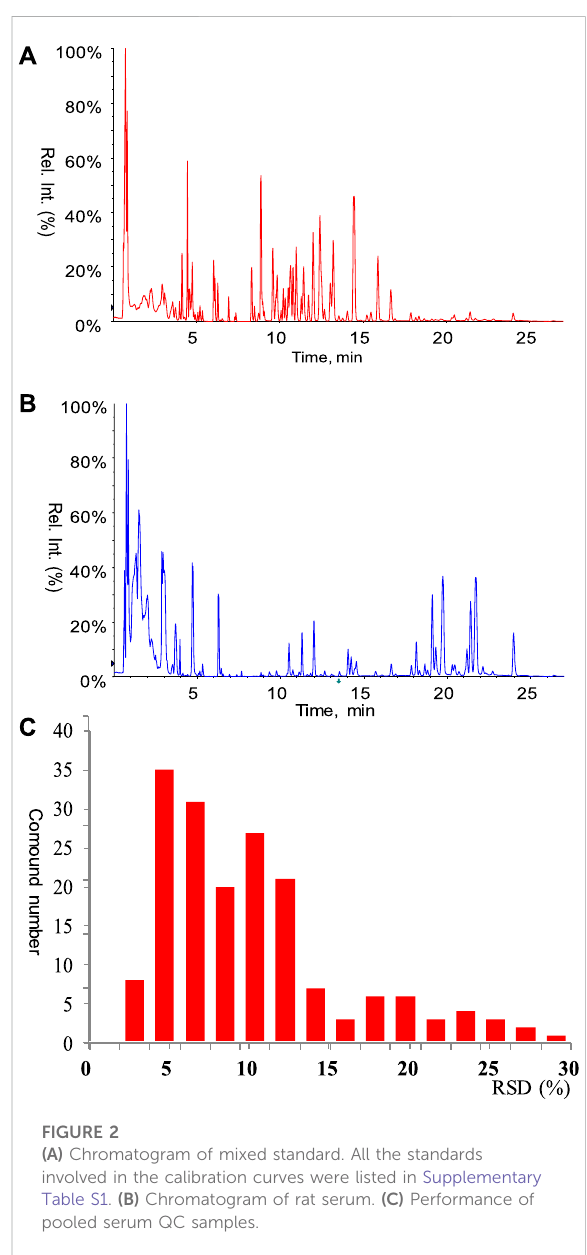
FIGURE 2 (A) Chromatogram of mixed standard. All the standards involved in the calibration curves were listed in Supplementary Table S1. (B) Chromatogram of rat serum. (C) Performance of pooled serum QC